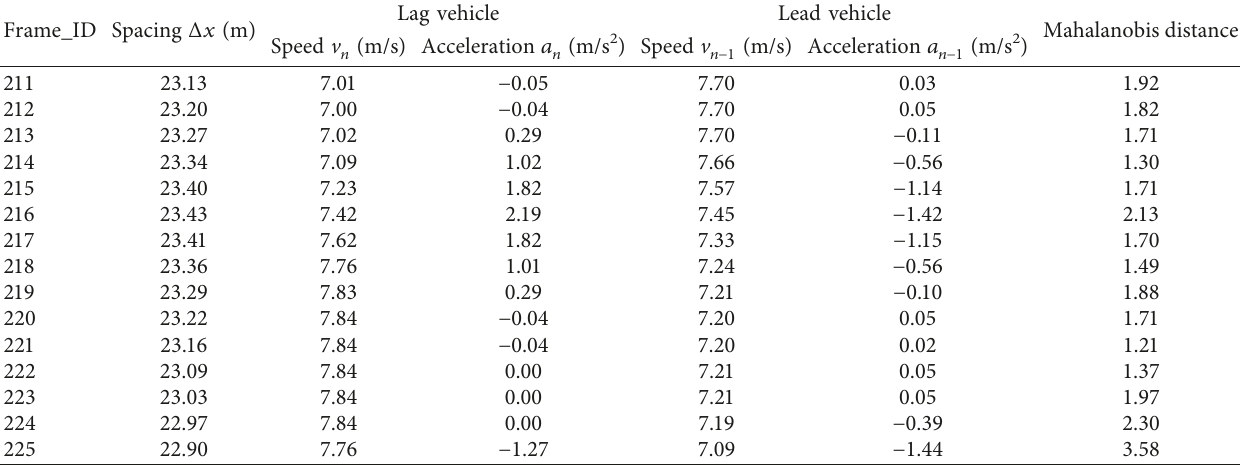
Table 2: Exemplary data entries associated with one car-following group of vehicles using travel lane 3 (1.5-second refreshing rate).